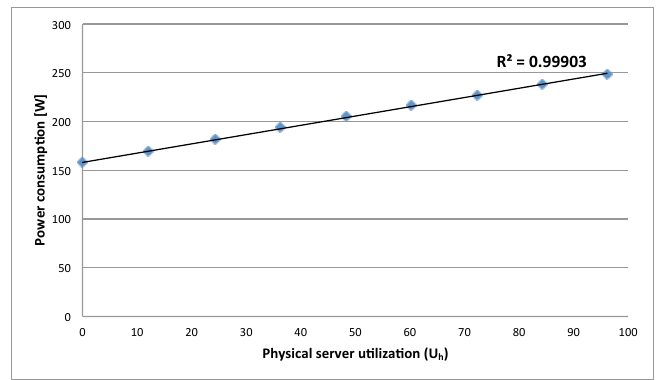
Figure 1. Power consumption in a single host depending on